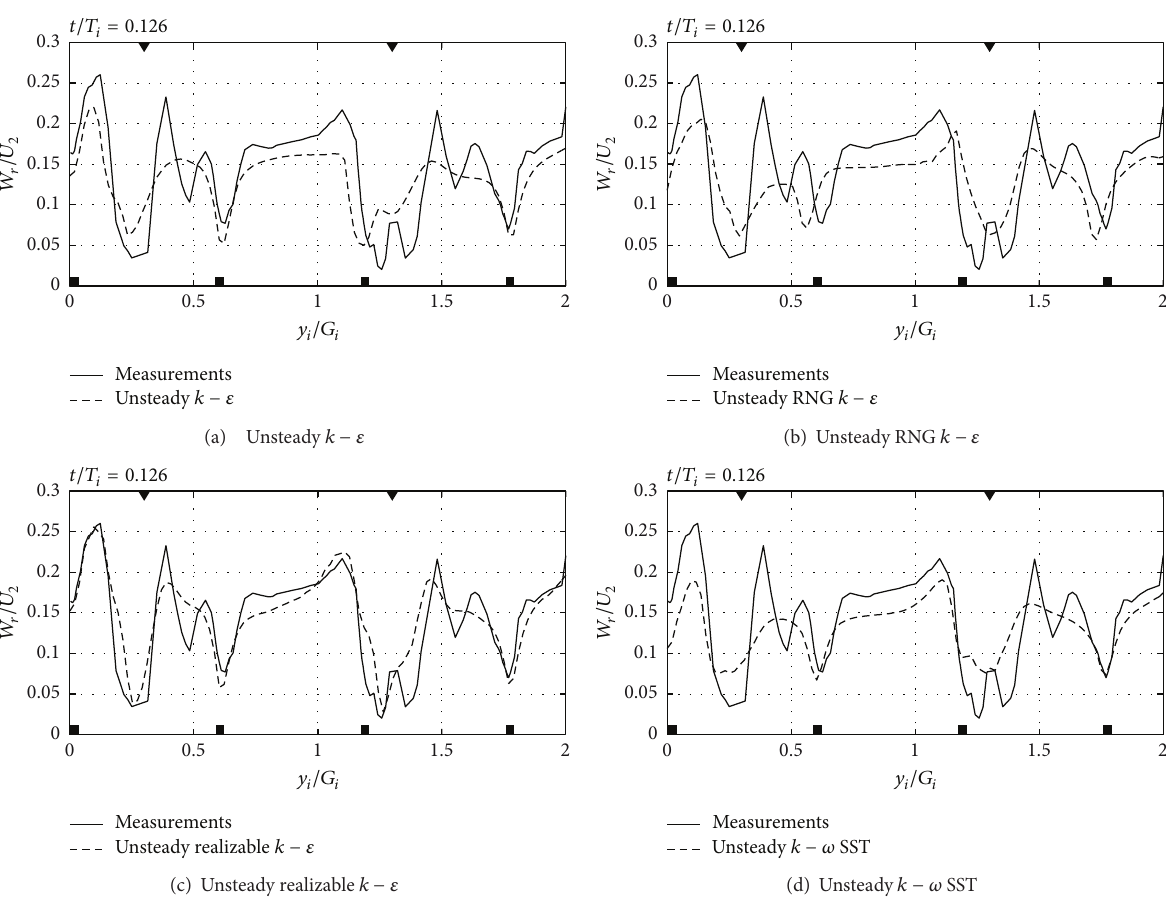
Figure 13: Radial velocity in the radial gap ( 𝑅/𝑅 2 = 1.02 ) at